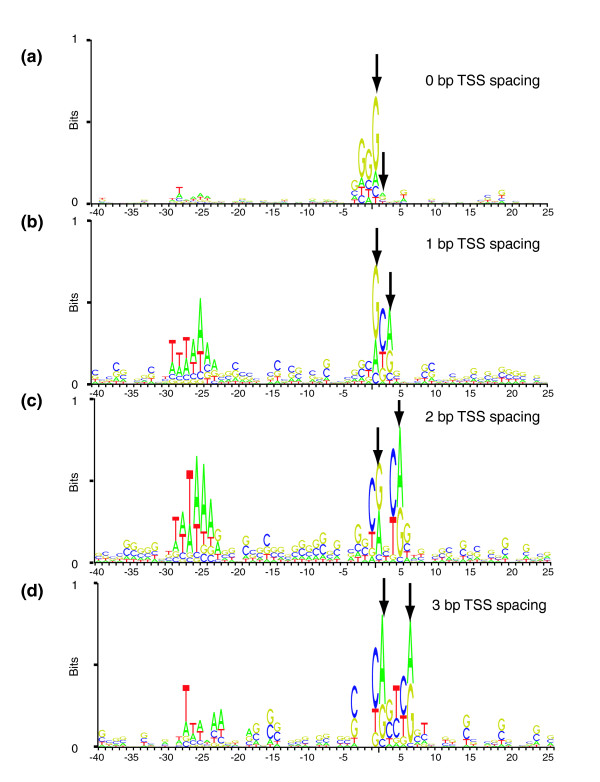
Exploration of SP-class promoters with twin-TSS. (a-d) Sequence logo representations of promoters with two close, dominant peaks separated by 0-3 bp. In contrast to previous sequence logos, we applied no constraint on TATA presence for promoter inclusion. Black arrows denote the location of the two dominant TSSs. The +1 position is arbitrarily defined as the position of the TSS located the furthest upstream. When there is no spacing between the peaks, promoters are depleted of TATA boxes. This type of promoter has an atypical initiation site consensus closely resembling that of transcripts in 3' untranslated region promoters [8]. More diverged peaks have a higher amount of TATA-like motifs around position -30 with respect to the most upstream peak. bp, base pairs; TSS, transcription start site.